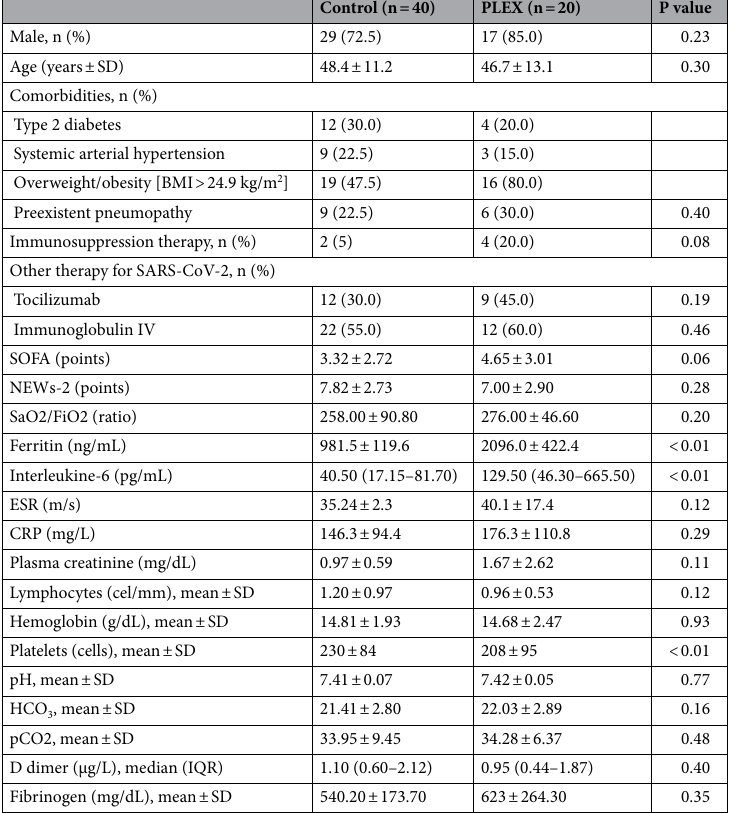
Table 1. Baseline characteristics of the study population. Qualitative data were expressed as n(%) and quantive data were expressed as mean ± standard deviation. Abbreviatures: PLEX, plasma exchange therapy; BMI, body mass index; SOFA, Sequential Organ Failure Assessment Score; CRP, C-reactive protein; ESR, erythrosedimentation